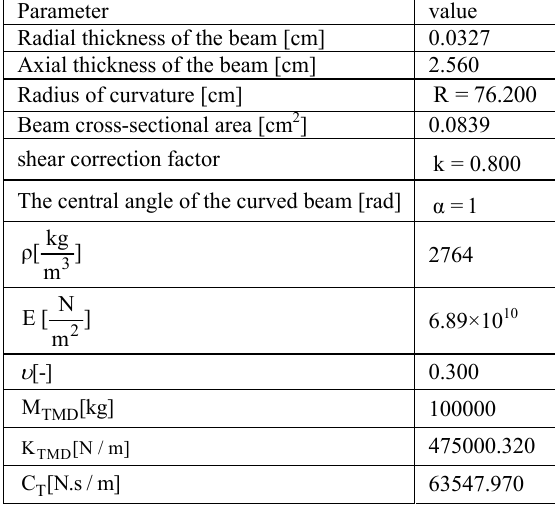
Table 1. Geometrical and physical data of the curved beam